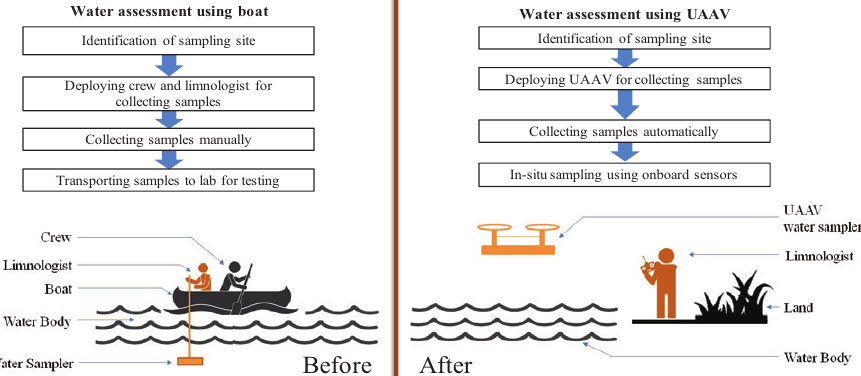
Figure 2. Storyboarding sketch - comparison of water quality assessment using boat and